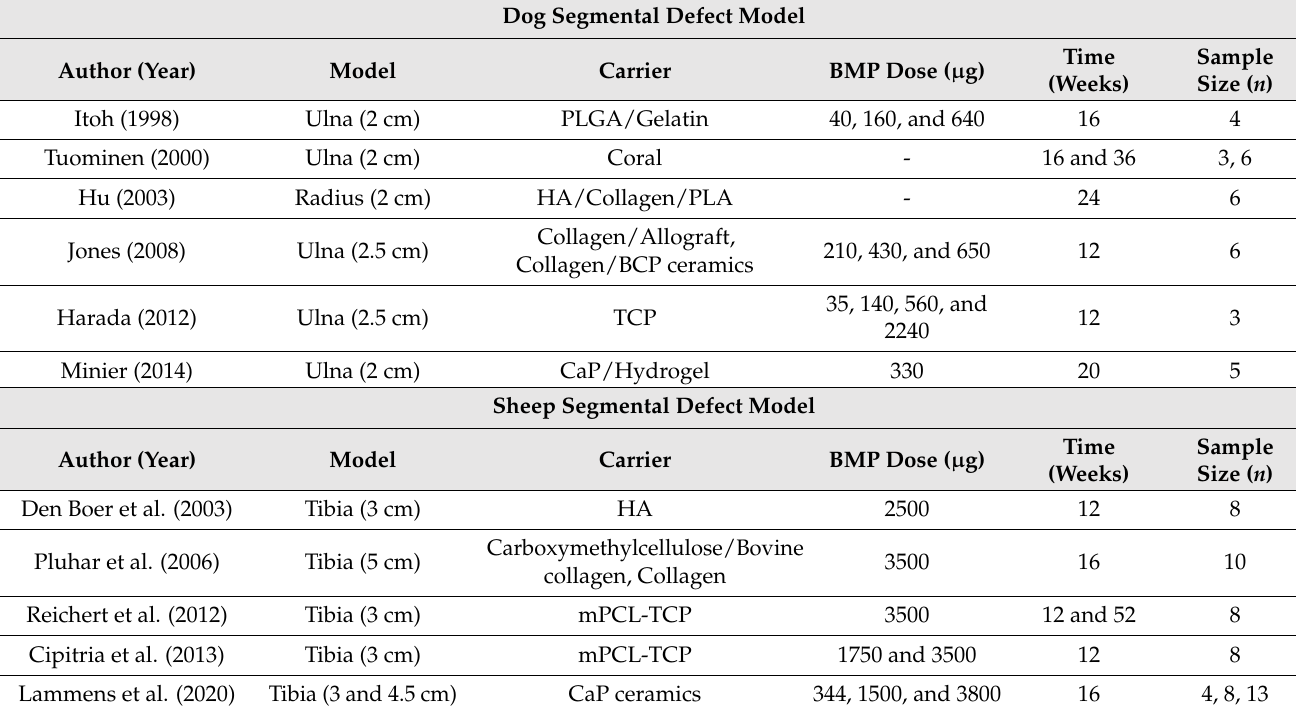
Table 5. Dog and sheep segmental defect model.